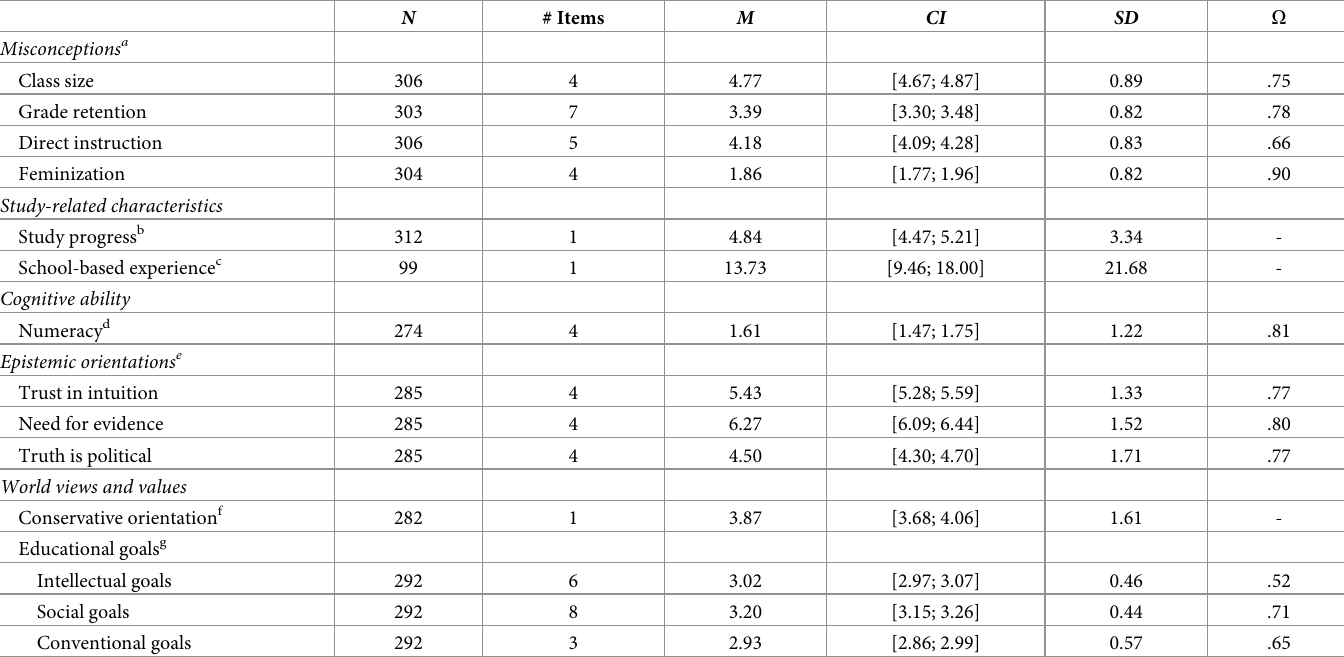
Table 2. Descriptive statistics of the educational misconceptions and predictors.